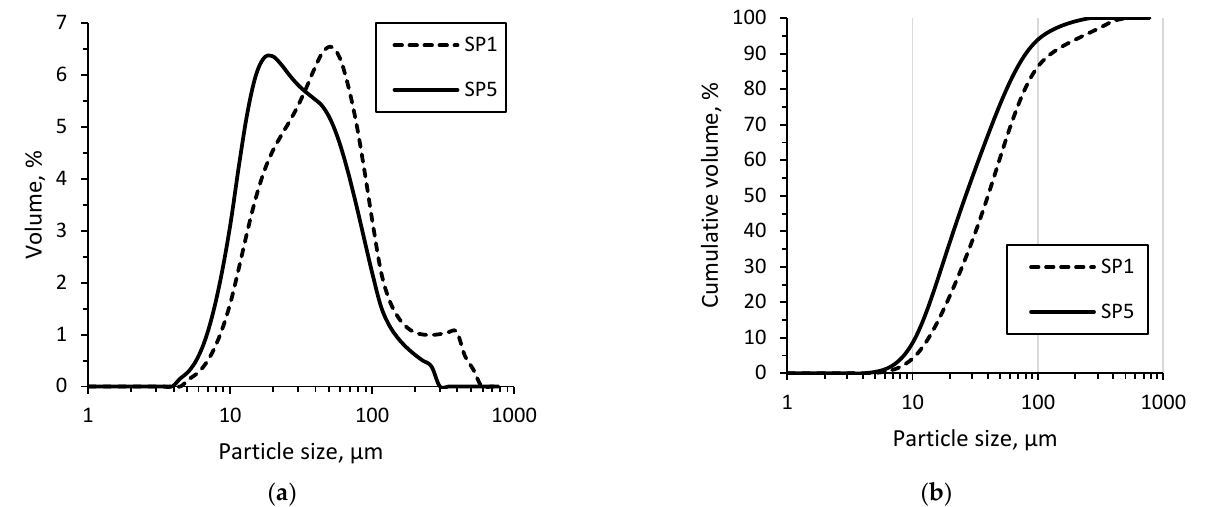
Figure 8. Particle size distribution of pure alloy 16-7-6 SP1 and 16-7-6 SP5 with maximum sulfur and phosphorus content ( a ); and cumulative volume of different size fractions ( b ) in this study.